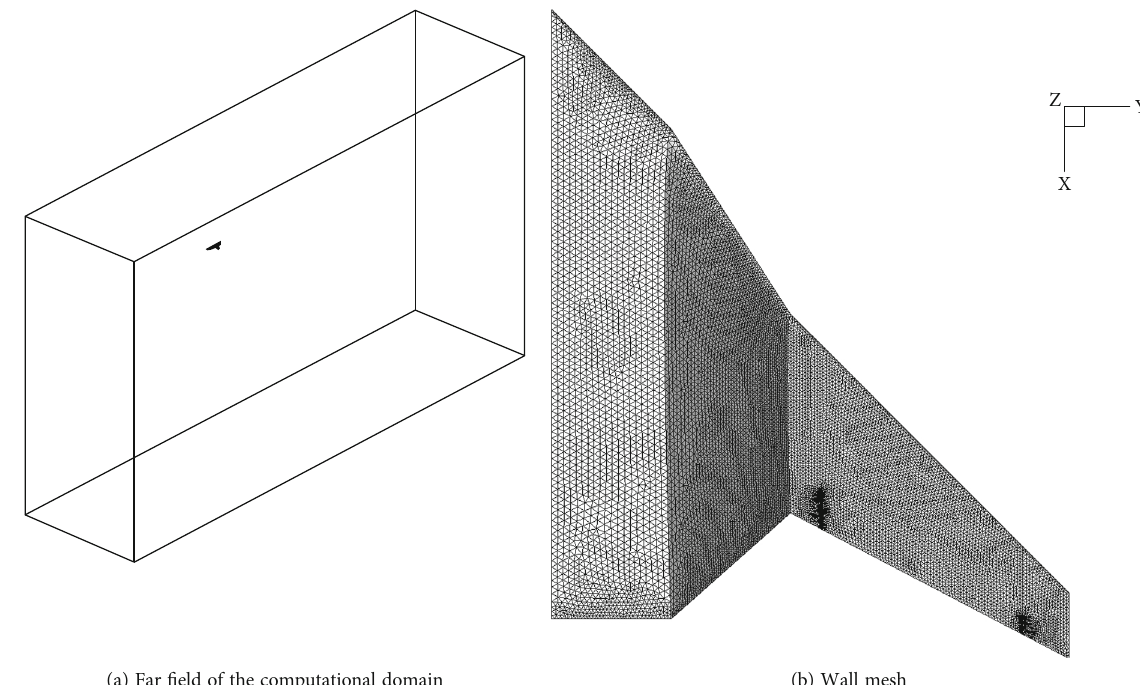
Figure 11: Mesh of the basic con fi guration with a 50 ° folding